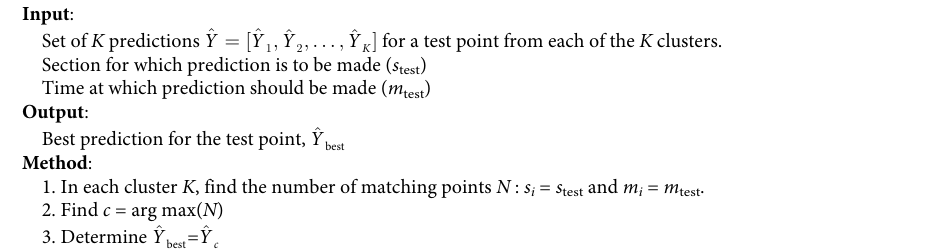
Table 2. Selection-based criterion.